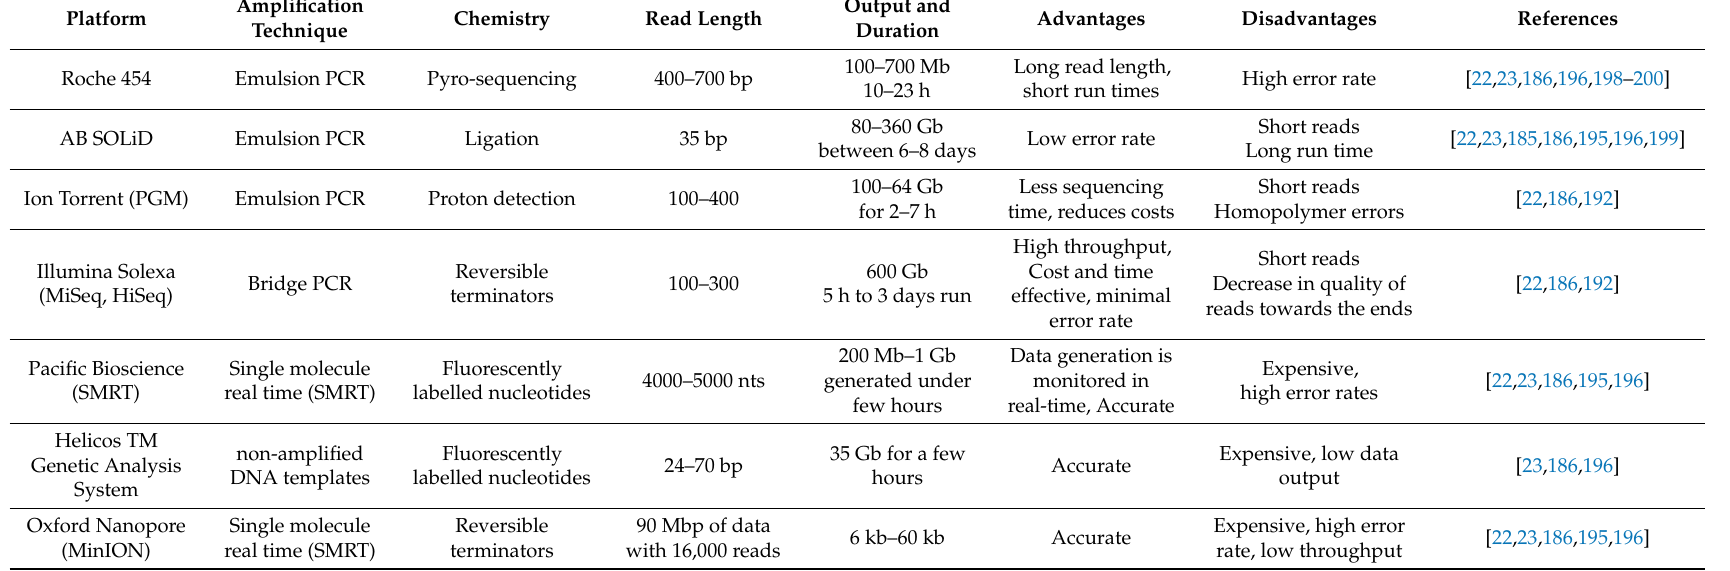
Table 5. Summary of the various features of the different second-generation platforms indicating strength and